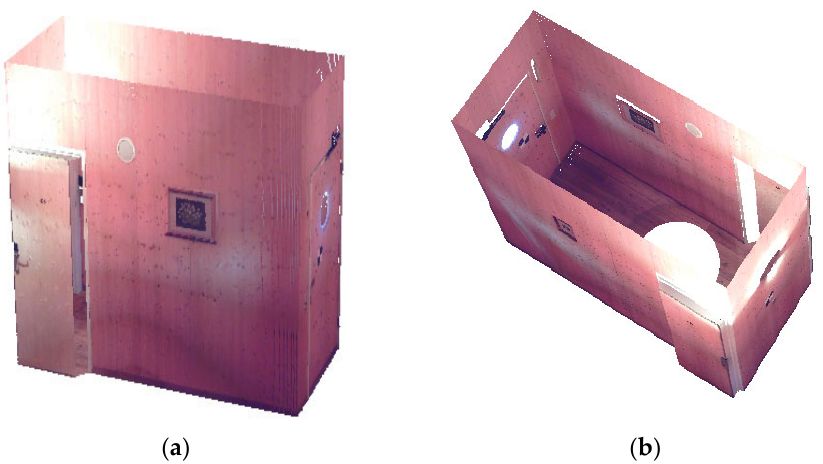
Figure 5. Raw point cloud data of the cottage: ( a ) front view and ( b ) top view.